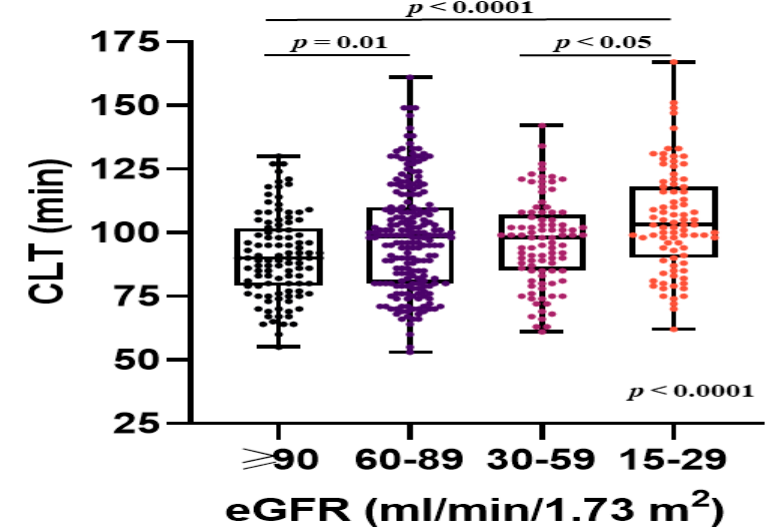
Figure 3. Associations between clot lysis time (CLT) and estimated glomerular filtration rate (eGFR) categories in patients with atrial fibrillation. Data are shown as medians (interquartile ranges) and maximum and minimum values.